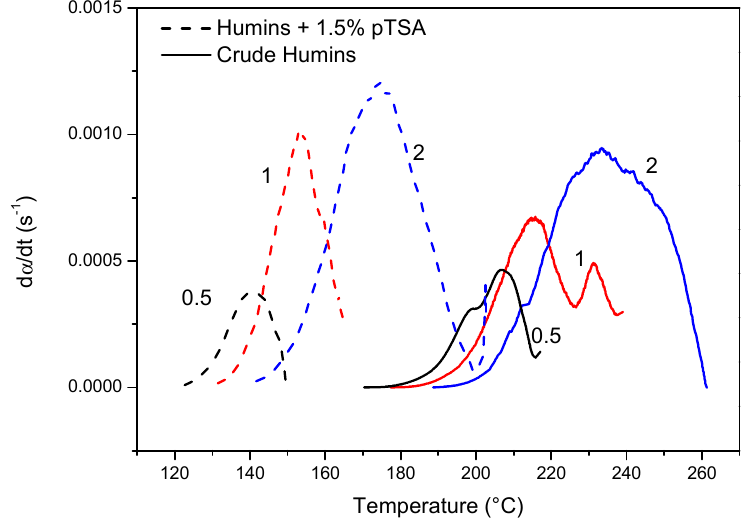
Figure 7. Reaction rate d α /d t versus temperature of crude humins (solid lines) and humins/pTSA (dash lines) at different heating rates. The heating rate of each experiment (in °C·min − 1 ) is indicated by each curve.